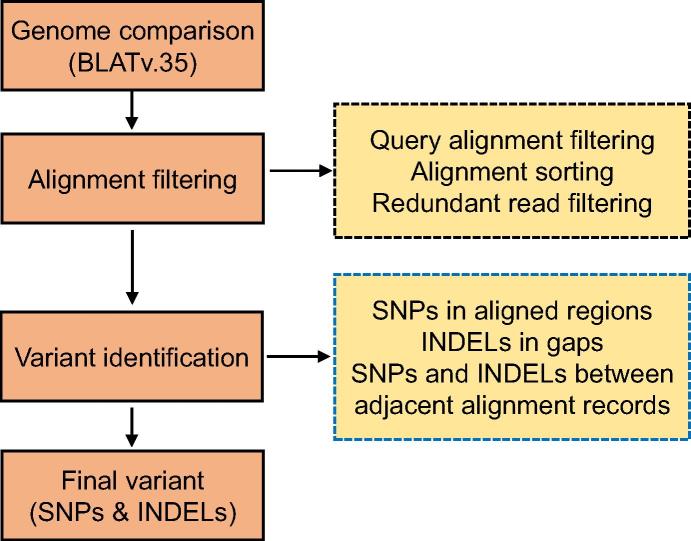
Workflow of variant identification based on genome comparison in RGAATFirst, the genome comparison is performed by BLAT and the redundant reads are filtered out by the combination of processes indicated in the box with dashed borders in black. Second, variants including SNPs and INDELs are identified as indicated in the box with dashed borders in blue. Finally, variants were ready for downstream analysis.